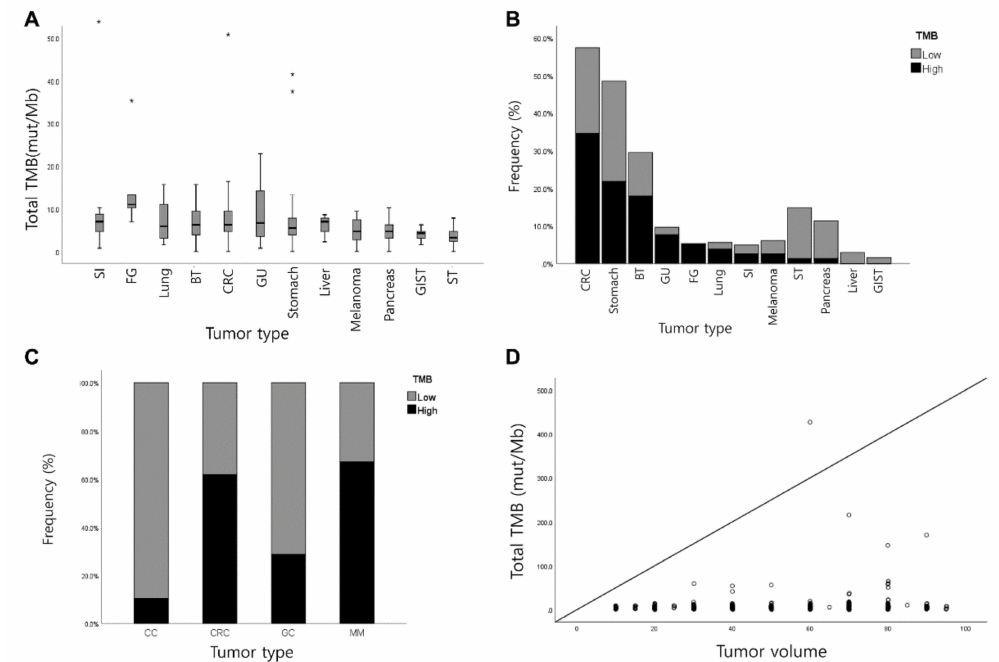
Figure 1. Tumor mutation burden (TMB) results in 588 cases. ( A ) TMB values across various tumor types. The highest average TMB was observed in the small intestine, followed by that in the female genital tract, lung cancer, biliary tract cancer, CRC, genitourinary tract cancer, GC, liver cancer, MM, GIST, and mesenchymal tumor. ( B ) The proportion of high-TMB (> 10 mut/MB) among tumor types in a total of 588 cases and ( C ) previously reported TCGA data. ( D ) Correlation between tumor volume and TMB. (*, outliers, Abbreviations: TMB, tumor mutation burden; SI, small intestine; FG, female genital tract, CRC, colorectal cancer; BT, biliary tract cancer; GC, gastric cancer; CC, cholangiocarcinoma; MM, melanoma; GIST, gastrointestinal stromal tumor; ST, soft tissue